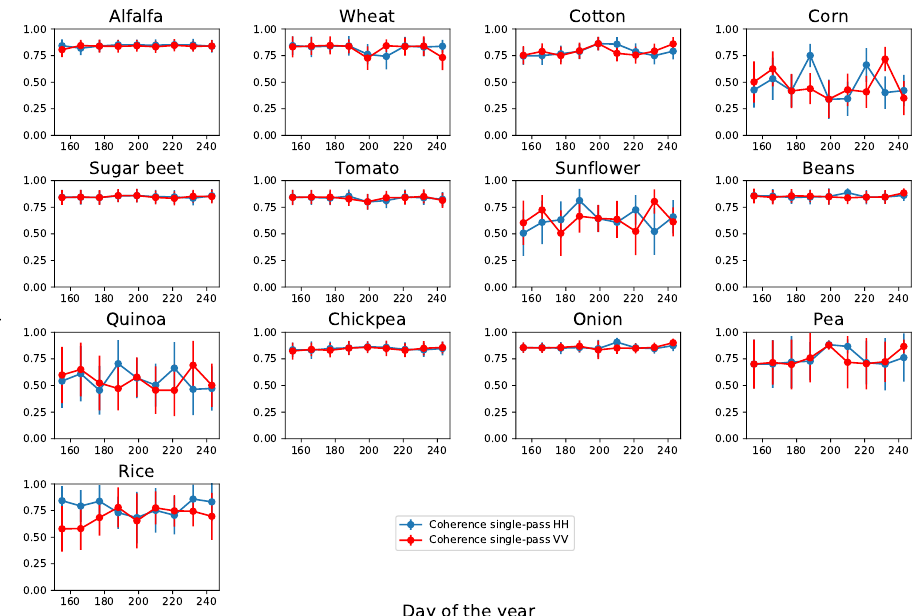
Figure 5. Temporal evolution of the single-pass interferometric coherence at HH (blue) and VV (red) channels for all crop types. Dots represent the average values and the error bars denote the standard deviation of the